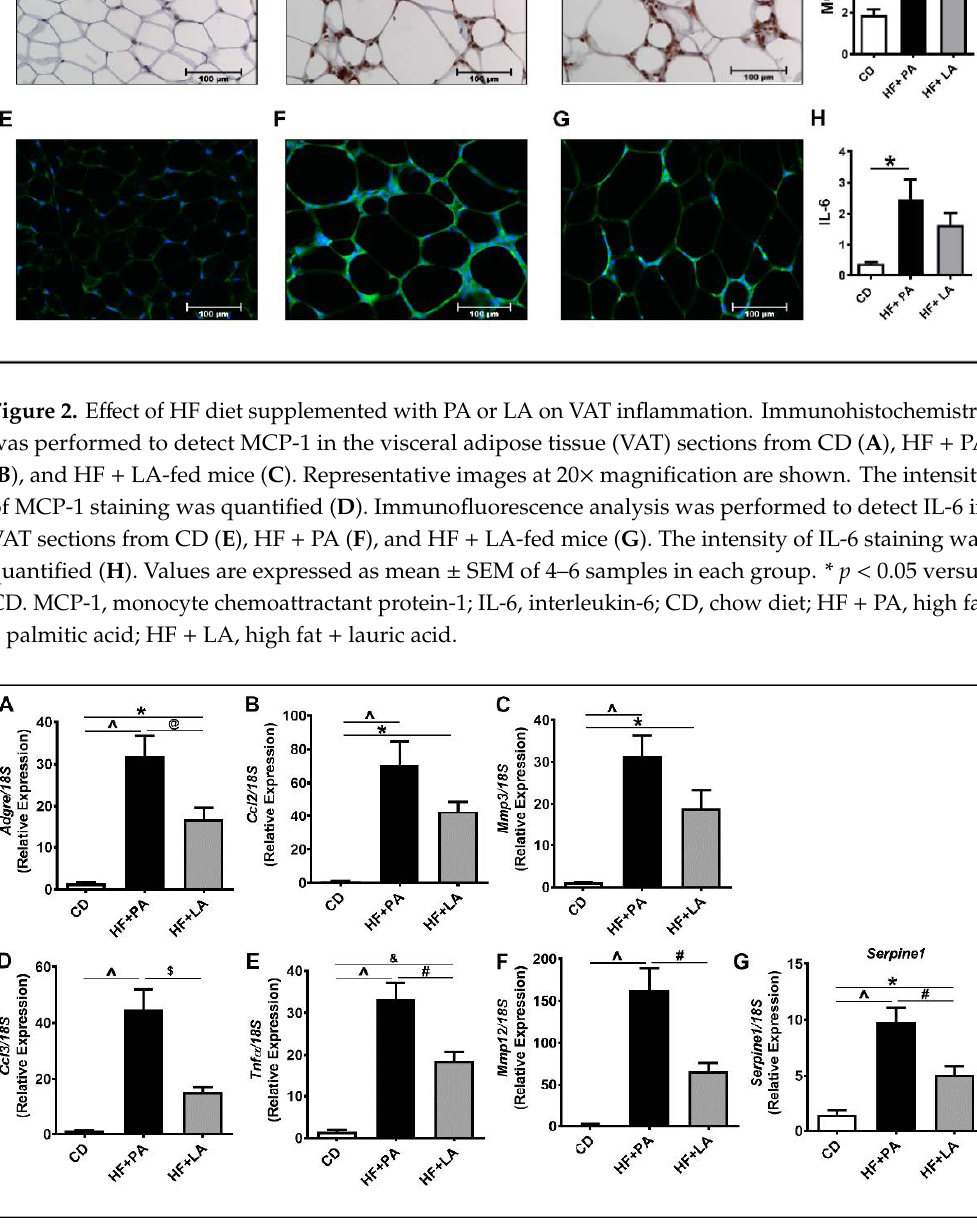
Figure 3. Effect of HF diet supplemented with PA or LA on the mRNA levels of inflammatory markers in VAT. Quantitative real-time PCR analysis was performed in the visceral adipose tissue (VAT) for the mRNA levels of Adgre , a macrophage marker ( A ) and other inflammatory genes ( B – G ). Values are expressed as mean ± SEM of 6–8 samples in each group. * p < 0.05, & p < 0.01, and ^ p < 0.001 versus CD; @ p < 0.05, # p < 0.01, and $ p < 0.001 versus HF + PA. Adgre1 (Emr-1) , EGF-like module containing, mucin-like, hormone receptor like 1; Ccl2, C-C chemokine ligand 2; Mmp3, Matrix metallopeptidase 3; Ccl3 , C-C chemokine ligand 3; Tnf α , Tumor necrosis factor, alpha; Mmp12, Matrix